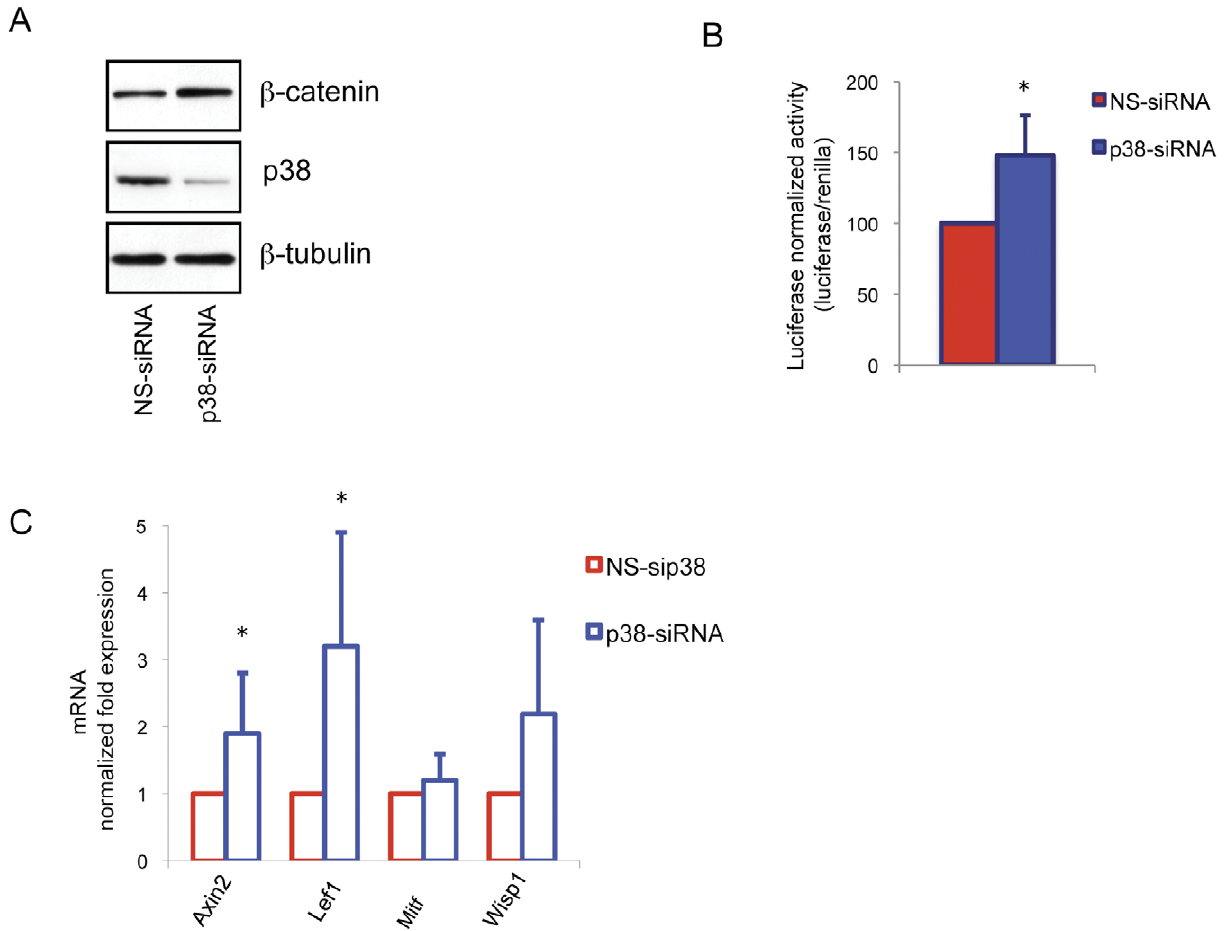
Figure 8. The effect of p38 silencing on Wnt/ b -catenin pathway signal transduction. (A) One representative western blot used to quantify p38-siRNA interference efficiency and b -catenin 24 h of transfection. Total cellular proteins (20 m g/lane) were subject to 10% SDS-PAGE. Variation of loading was determined by blotting with anti- b -tubulin antibody. Western blot assays are representative of at least three experiments. (B) Luciferase activity of TopFlash reporter plasmid in cells transfected with p38-siRNA and NS-siRNA. Luciferase activity was assayed after 24 h of transfection. Firefly luciferase activity, normalized to the corrisponding renilla luciferase activity was expressed as fold change compared with control cells. Values represent mean 6 SD of three representative experiments performed in duplicate. (C) Semi-qunatitative real-time PCR was used to measure Wnt/ b - catenin-target genes Axin2, Lef1 and Wisp1 mRNAs expression in B16-F0 cells after 24 h of transfection with p38-siRNA. The graphs show fold differences in transcript abundance in comparison with non-specific siRNA-treated cells. Results shown were normalized by the b -actin mRNA levels. The data show the mean 6 SD of three experiments performed in triplicate. *P # 0.05 versus control.